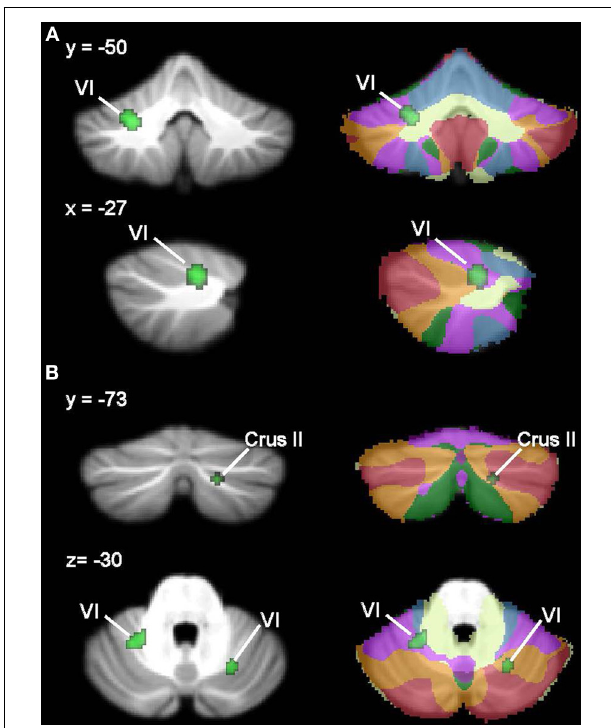
FIGURE 5 | Dyslexia < TD GM: whole-brain and ROI analyses. Left (A) , Regions in the whole-brain analysis showing significant ALE voxels where Dyslexia < TD (green), thresholded at p < 0 . 001, k > 50. (B) Regions showing Dyslexia < TD in the ROI analysis. Right, corresponding slices showing functional connectivity maps of the cerebellum (Buckner et al., 2011). Networks are color-coded such that blue, somatomotor; green, dorsal attention; violet, ventral attention; cream, limbic; orange, frontoparietal; red, default network. network (right Crus I cluster). In dyslexia, the left VI clus- ventral attention network ( Figure 5 , right); the clusters